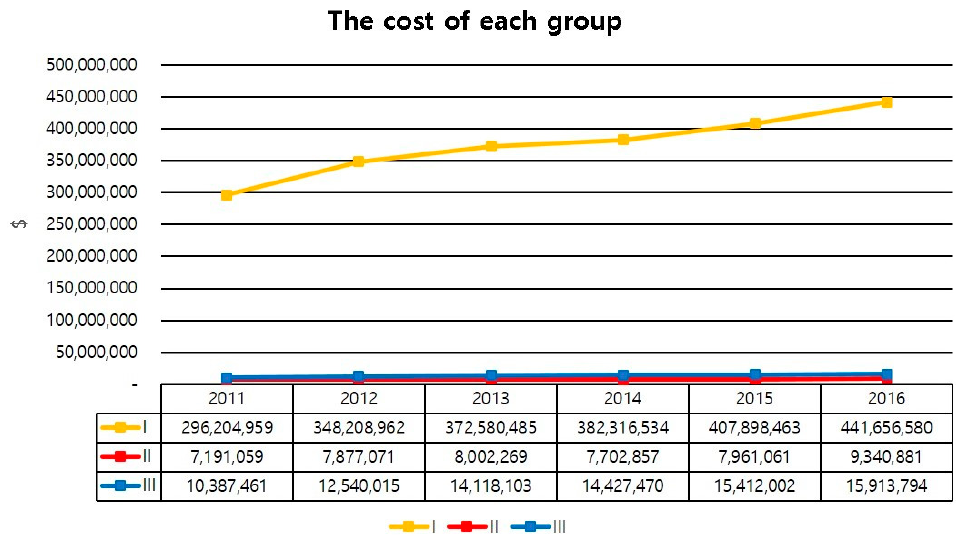
Figure 5. The direct cost of each group for diabetic foot ulcer with PAD.